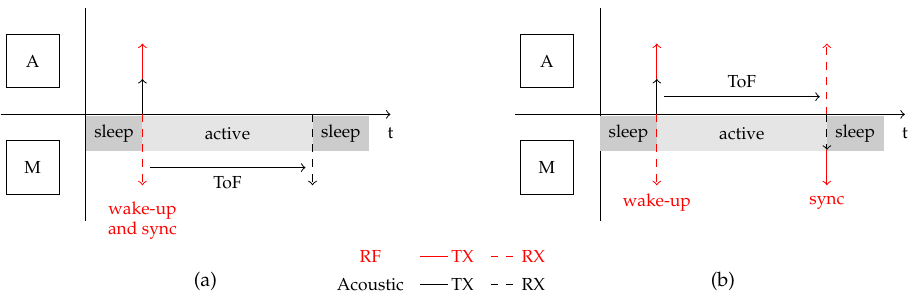
Figure 3. Two hybrid RF-acoustic ranging strategies considering acoustic transmission by the anchor node(s). The ToF is either measured by ( a ) the mobile device M or ( b ) the anchor node A. In each case, the mobile device needs to actively wait for the arrival of the acoustic signal, which entails poor energy efficiency.